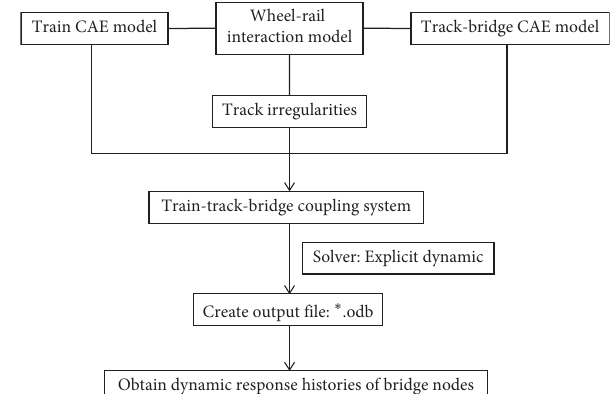
Figure 8: Track irregularity: (a) vertical; (b) lateral.